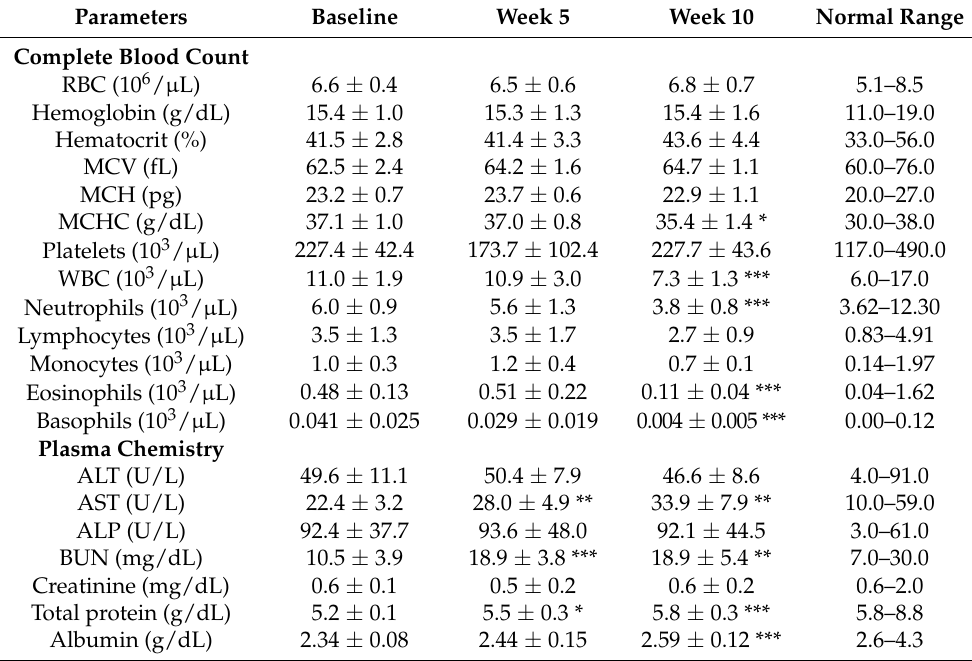
Table 4. The complete blood count (CBC) and plasma chemistry profiles obtained from seven dogs at baseline, week 5, and week 10 after exposure to EMR from